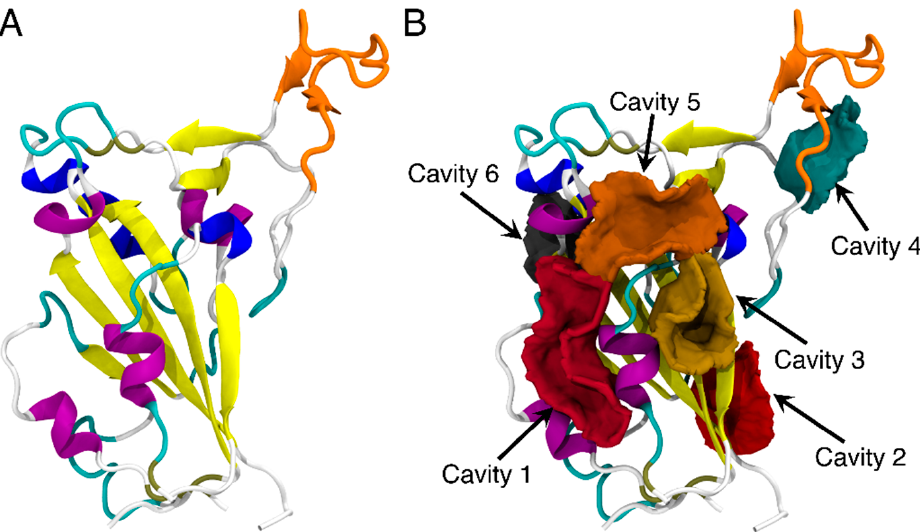
Figure 1. The structure of RBD of SARS-CoV-2 ( A ) and the predicted binding sites of RBD through CavityPlus analysis ( B ). The detected cavities are distinguished and represented in different colors. The RBD protein is shown in the cartoon representation. The T470-F490 loop is shown in orange, while the rest of the protein is colored by the secondary structures.